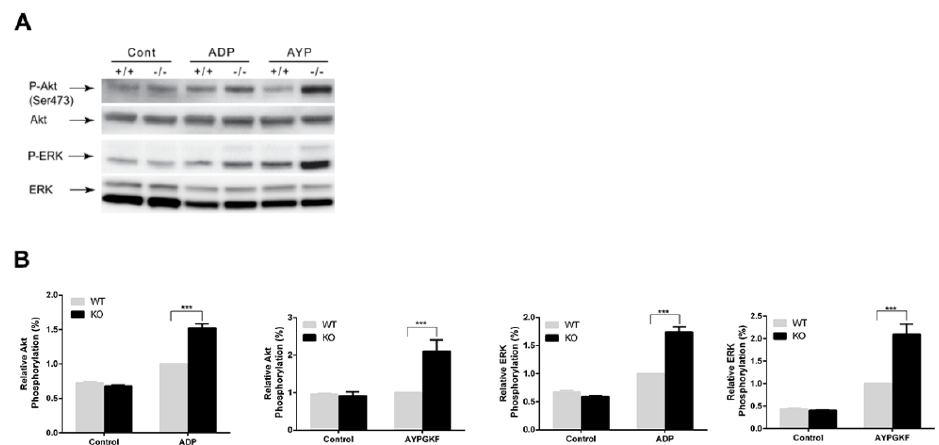
Figure 5. Enhancement of GPCR-mediated signaling events in arrestin3-deficient platelets. ( A ) Platelets from arrestin3 +/+ and − / − mice were stimulated with 50 nM 2-MeSADP and 100 µM AYPGKF for 2 min and probed with anti-phospho-Akt (Ser 473 ), anti-phospho-ERK, anti-Akt, or anti-ERK antibodies. ( B ) Data are presented as mean ± SE. ***, p < 0.005. Statistical analyses were performed by Student’s t-test using Prism software. Data are a representation of at least three experiments.